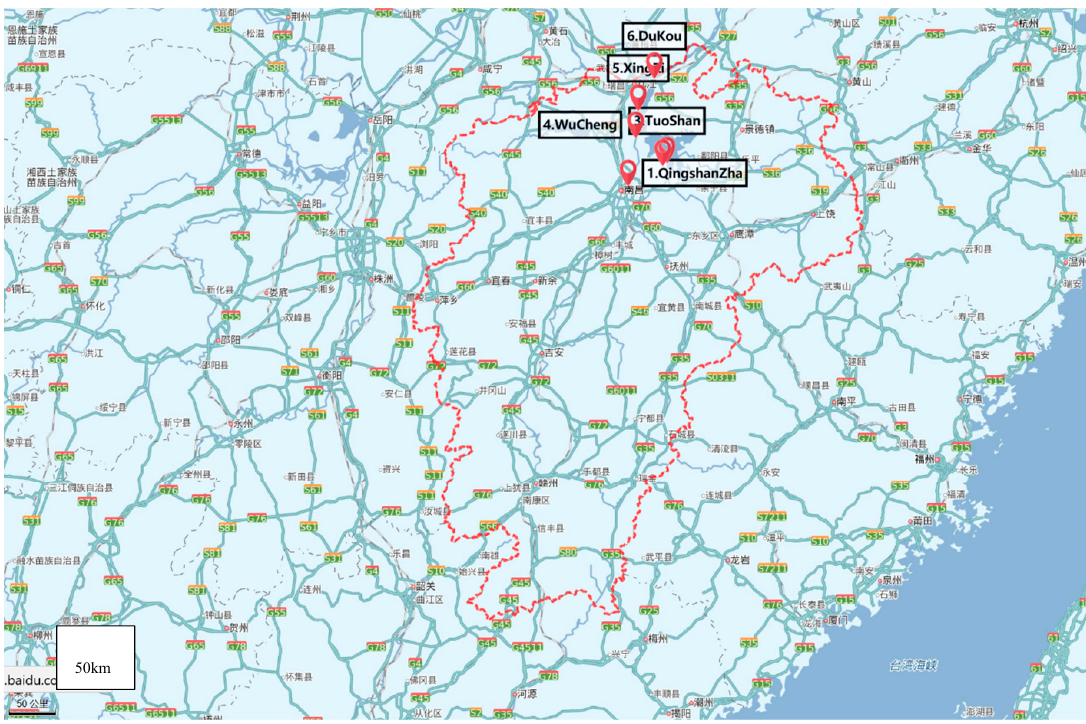
Figure 2. Distribution of sampling sites in Jiangxi Province.